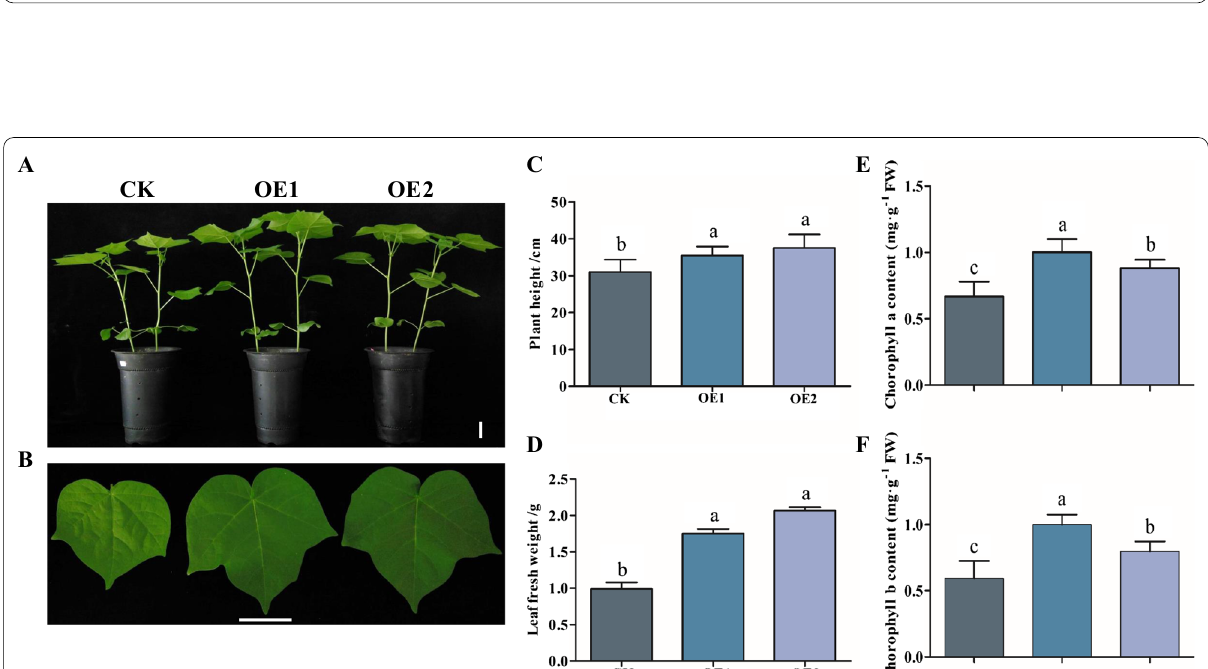
4 cm. B Biomass of root and shoot. Results are average values =